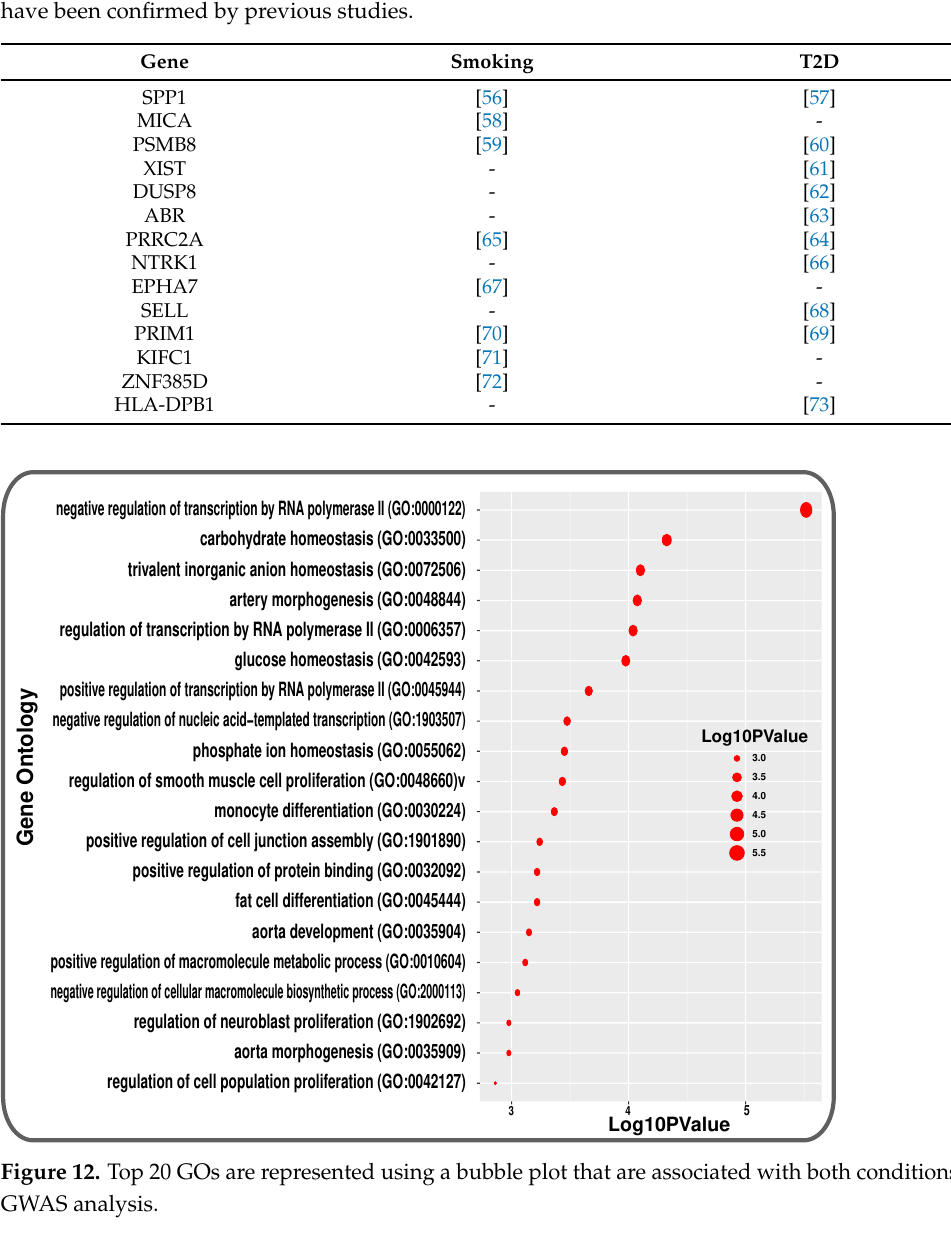
Table 2. Identified possible target genes or biomarkers that are shared by smoking and type 2 diabetes have been confirmed by previous studies.